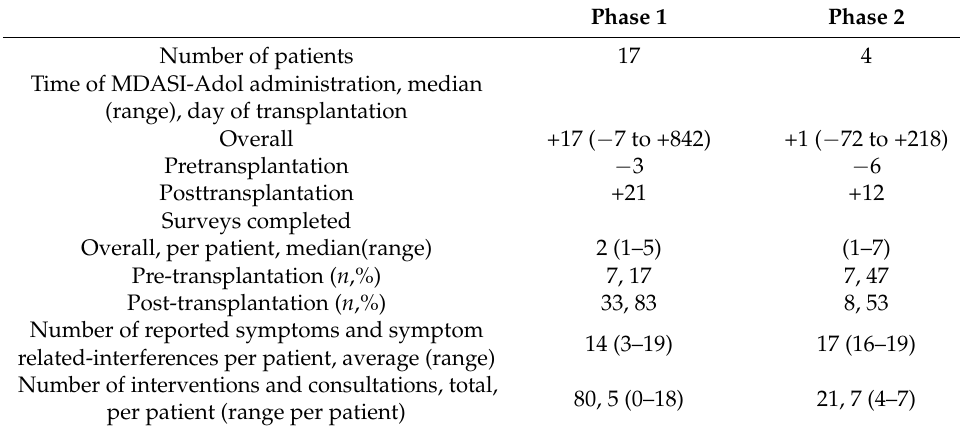
Table 4. Characteristics of MDASI-Adolescent (MDAS-Adol) surveys completed in both phases of